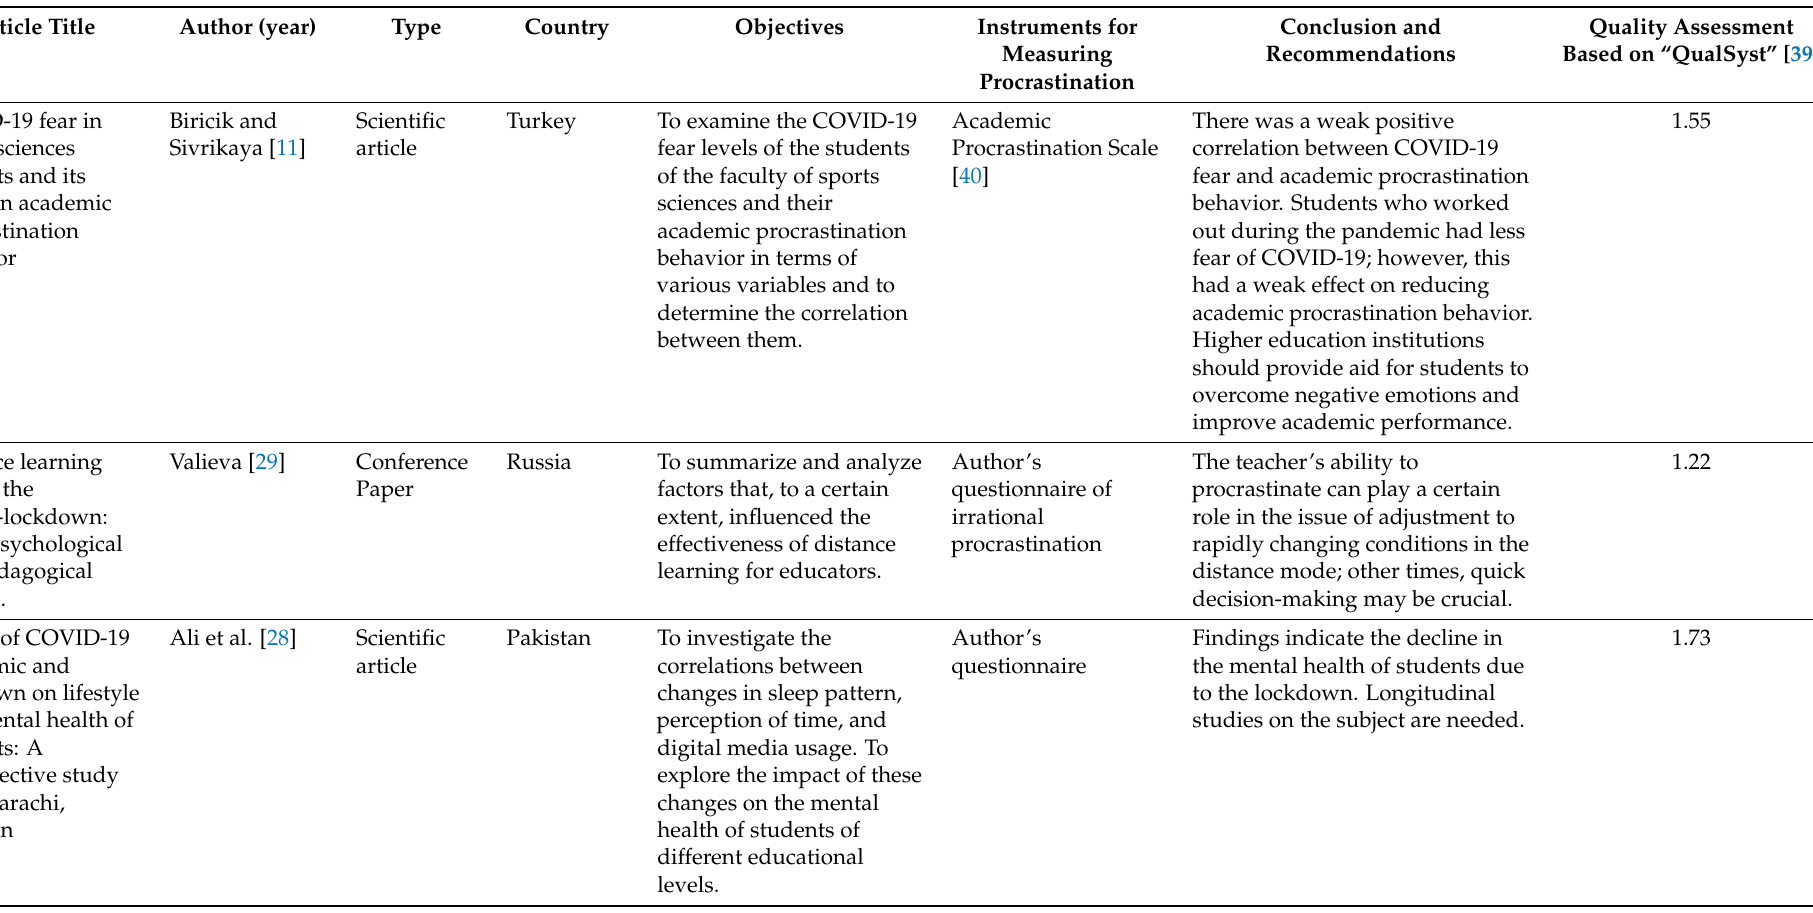
Table 1. General information of selected